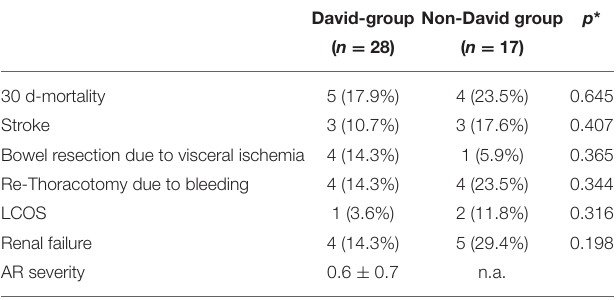
TABLE 3 | Thirty days follow-up.